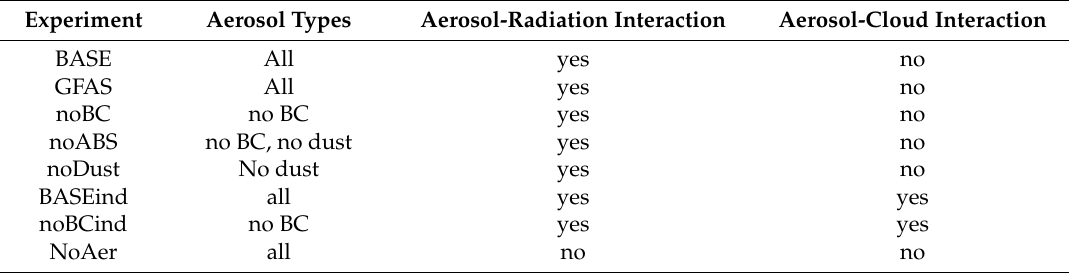
Table 1. List of model experiments, summarizing the included aerosol species and information whether aerosol-radiation and aerosol-cloud activation is computed prognostically using the simulated aerosol distributions. In the experiment GFAS the aerosol emissions from fires are computed using the GFAS dataset [34], all other cases are simulated with ACCMIP